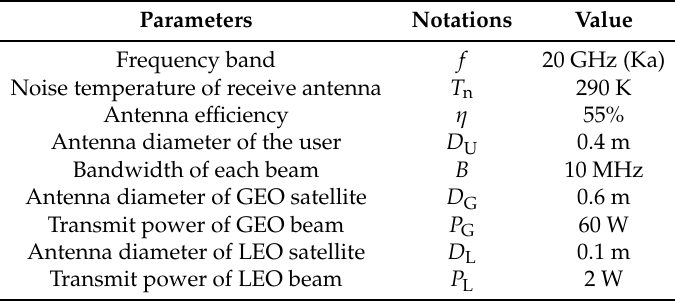
Table 2. Parameters of the GEO and LEO systems.